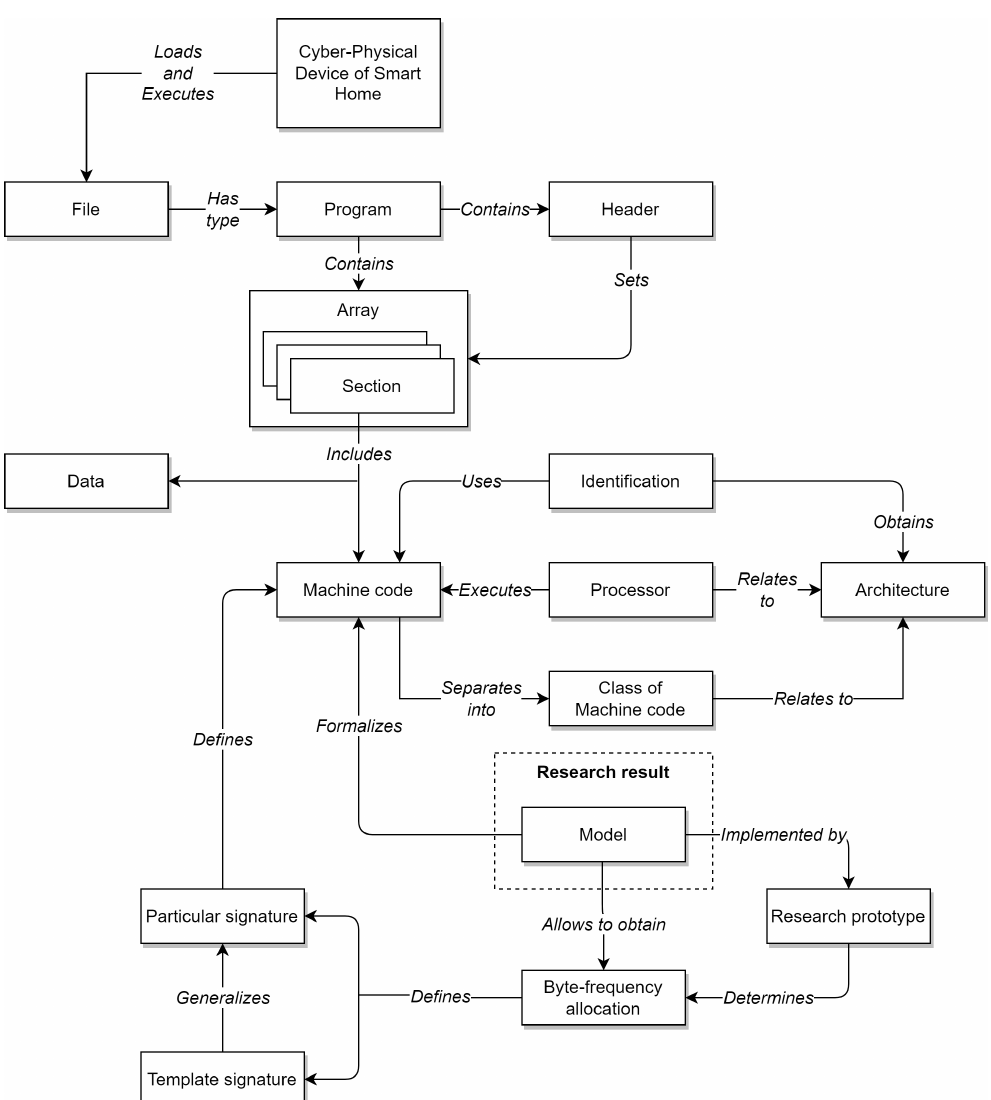
Figure 1. Ontological model of the